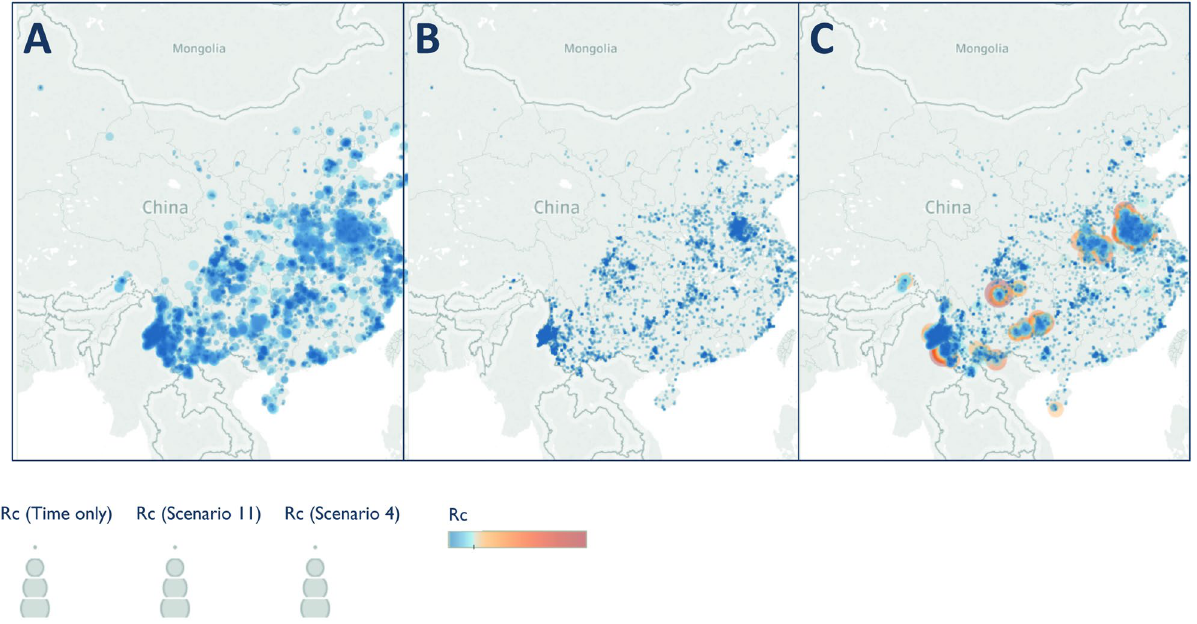
Figure 8. Map of Rc estimates for P. vivax in China Map of ( A ) time-only ( B ) best scenario by AIC (Scenario 11) and ( C ) Scenario 4, representing an assumption of little long-distance transmission and few unobserved cases.